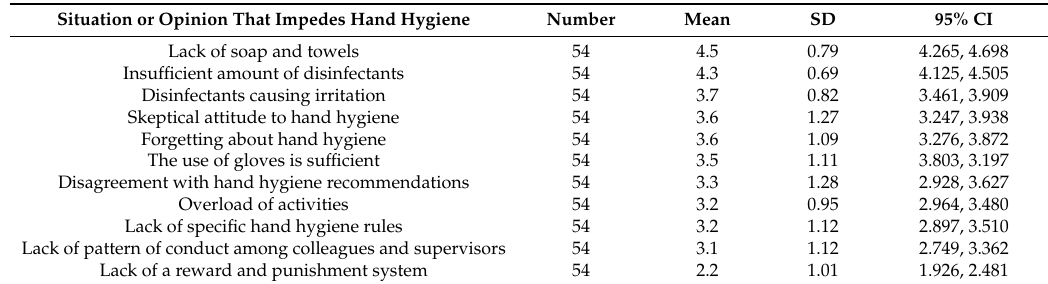
Table 5. Answers to the question: What situations encountered in everyday work affect compliance with HH recommendations? SD—standard deviation; 95% CI.